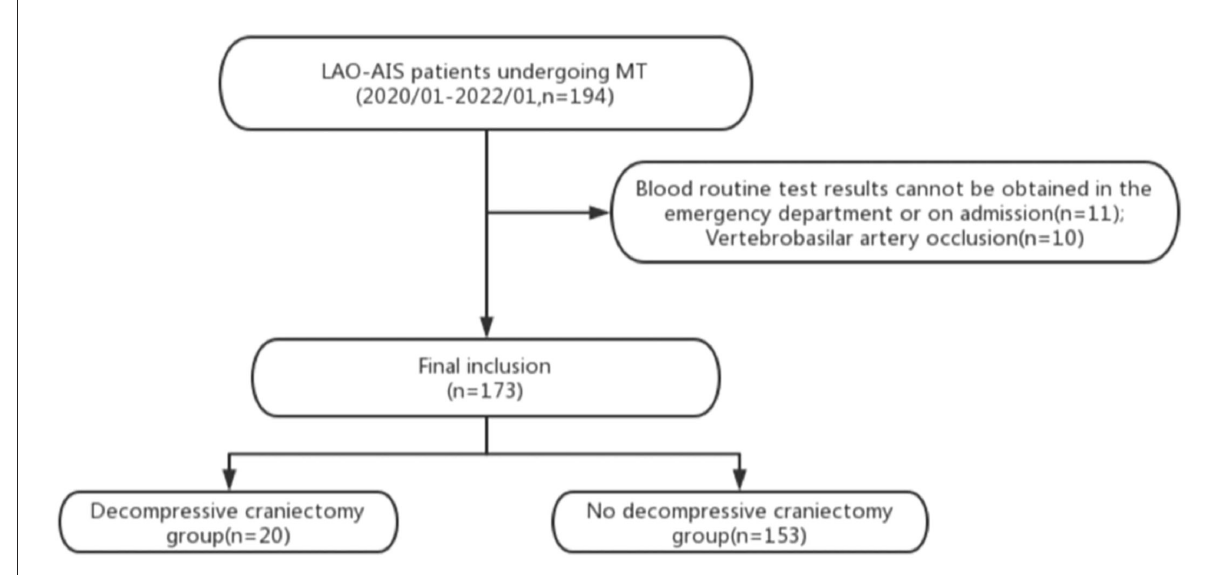
FIGURE1 Flow chart of this study. LAO-AIS, large-arterial occlusion acute ischemic stroke; MT, mechanical thrombectomy.